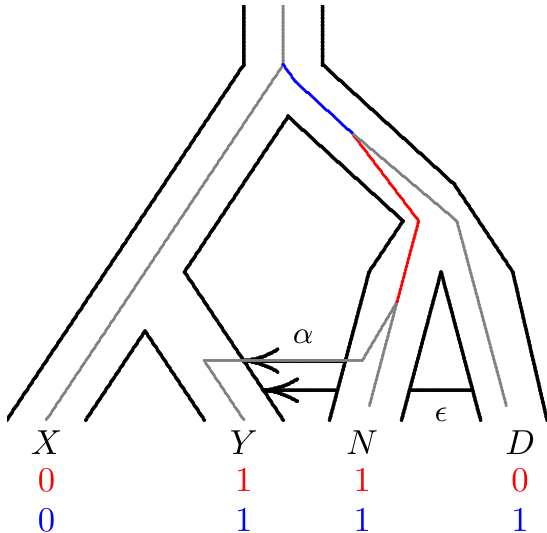
Figure 1 – Population network with embedded gene tree. A mutation on the solid red branch would generate site pattern yn (shown in red at the base of the tree). One on the solid blue branch would generate ynd . “0” and “1” represent the ancestral and derived